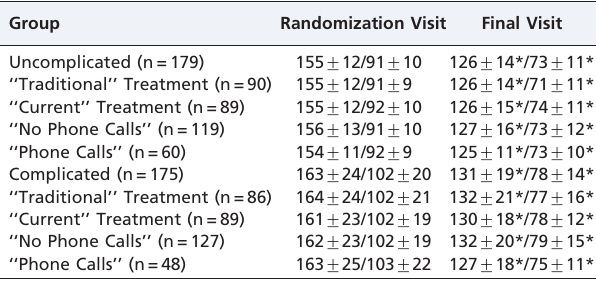
Table 2 - Blood pressure (mmHg) at the beginning and end of the 12-month treatment in the ‘‘uncomplicated’’ and ‘‘complicated’’ groups, according to the ‘‘traditional’’ and ‘‘current’’ treatments and randomization into the ‘‘phone calls’’ and ‘‘no phone calls’’ groups.